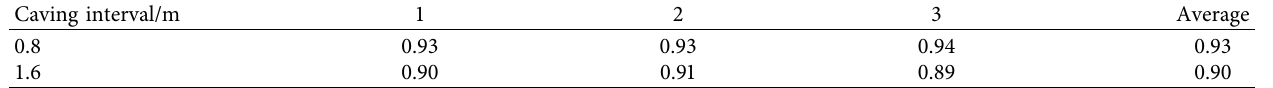
Table 8: Statistics of recovery of top coal under different coal caving intervals.